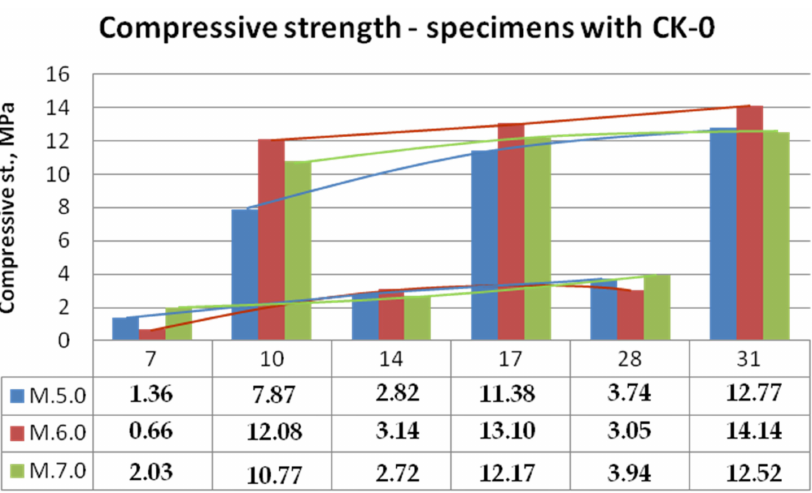
Figure 16. Compressive strength of mortars with kaolin clay.